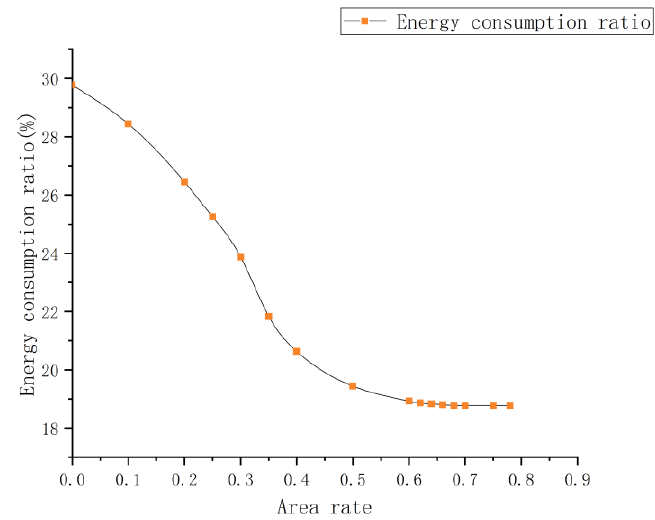
Figure 10. Energy consumption with different area ratio textured.